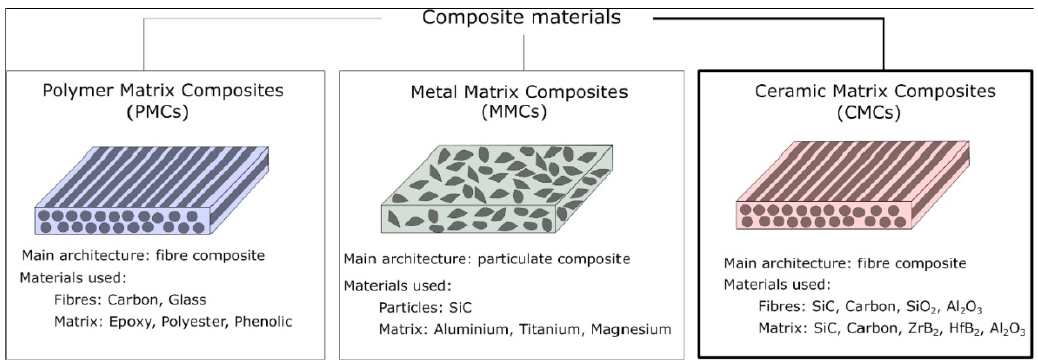
Figure 7. Variations in matrix-based composites [108].